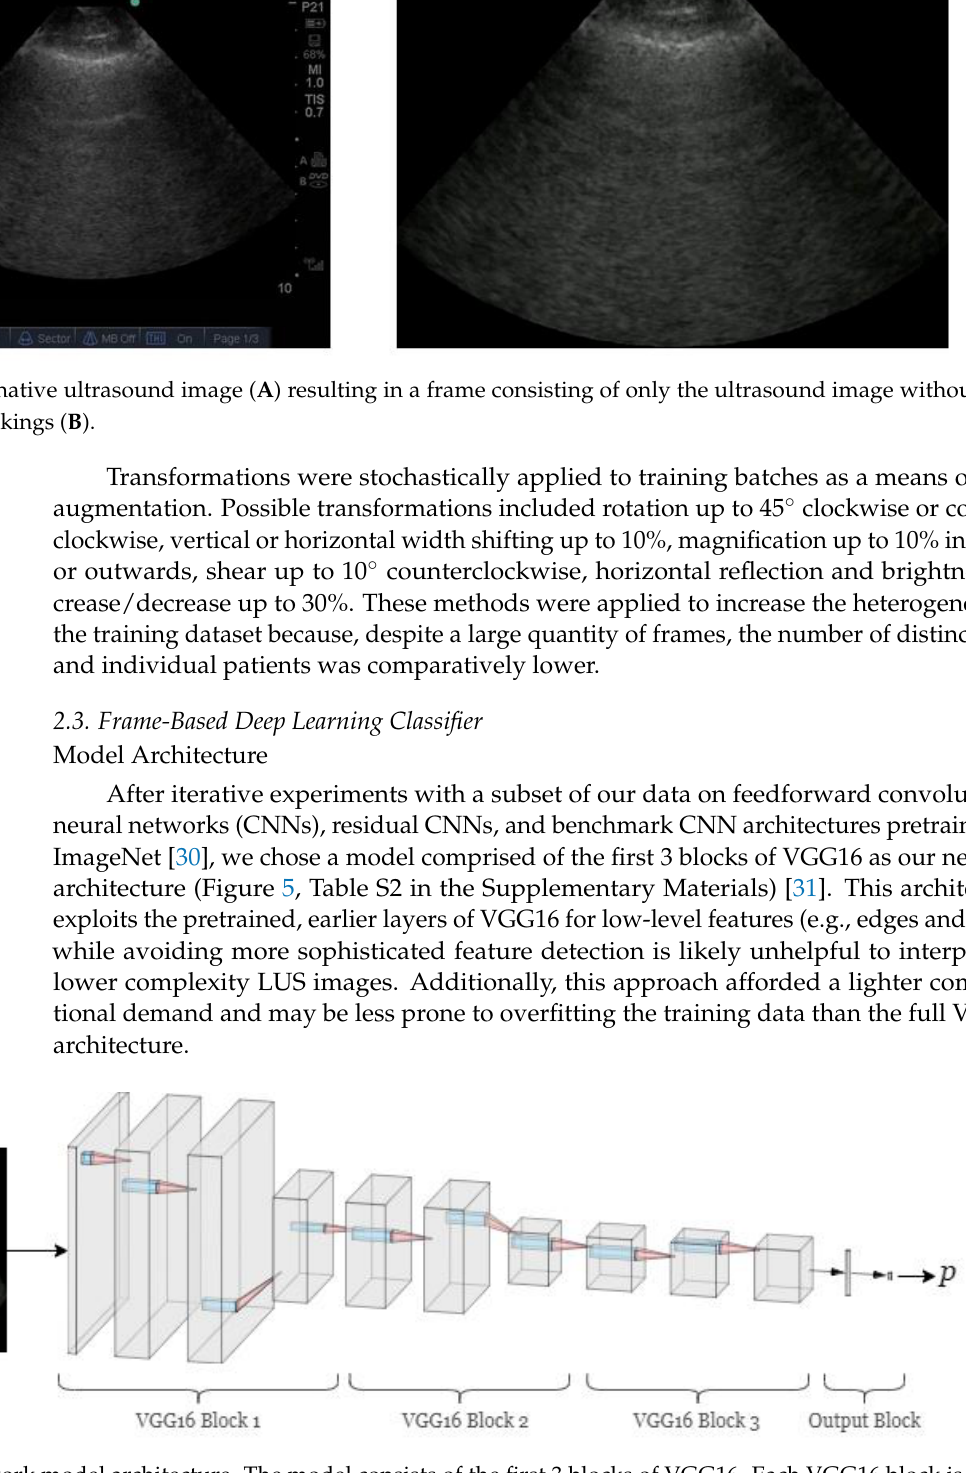
series of single-stride convolutions with 3 × 3 filters, followed by a 2 × 2 maxpool operation. The maxpool layer of the third